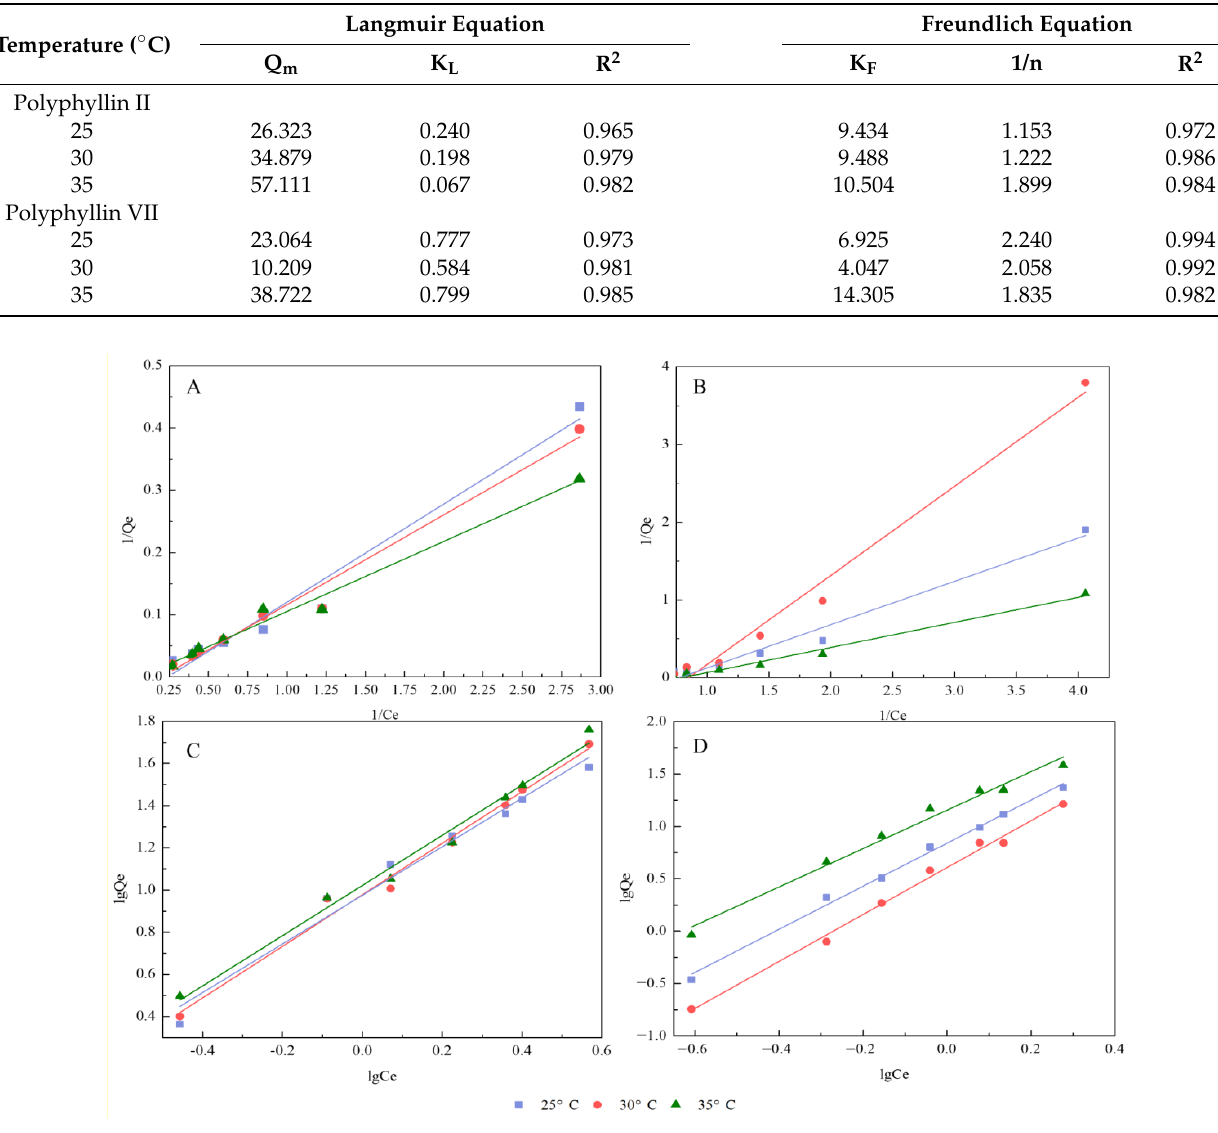
Figure 7. Linear correlation of polyphyllin II on NKA-9 at 25 °C, 30 °C, and 35 °C on the basis of the Langmuir ( A ) and Freundlich ( C ) models. Linear correlation of polyphyllin VII on NKA-9 at 25 °C, 30 °C, and 35 °C on the basis of the Langmuir ( B ) and Freundlich ( D ) models.